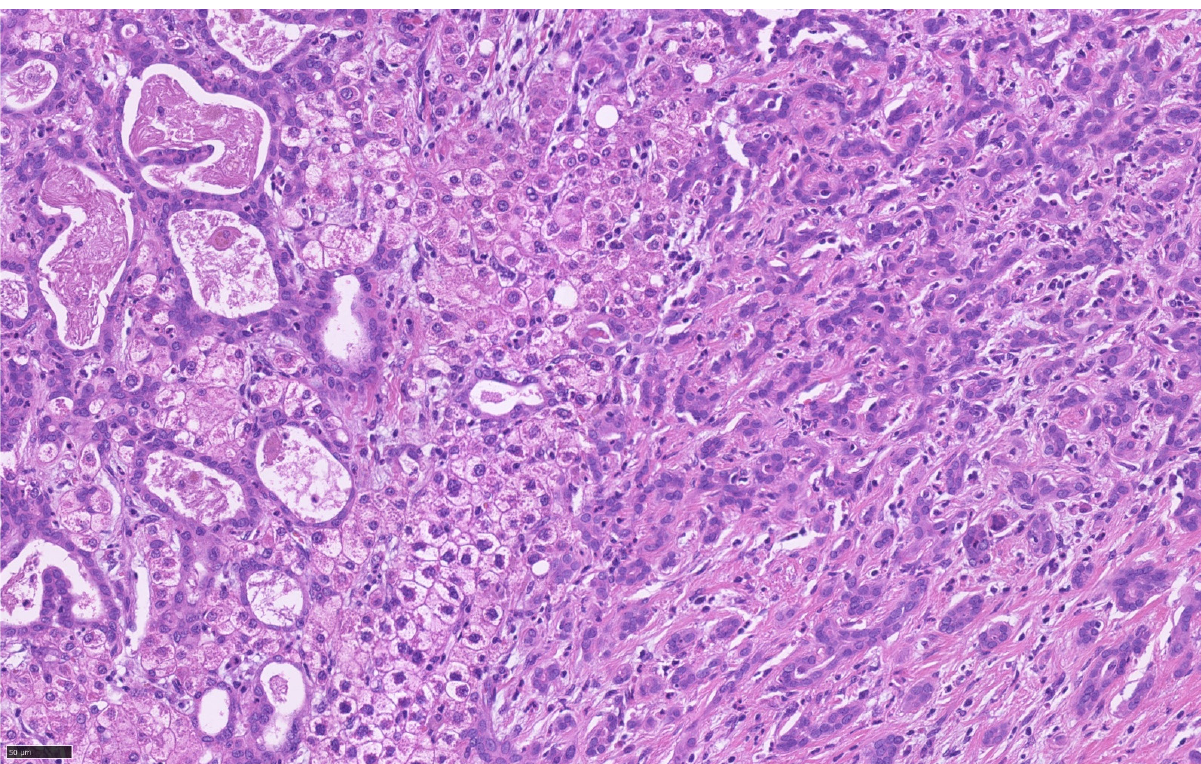
Figure 5. Tumor heterogeneity of cHCC-CCA which exhibits large duct iCCA component (left), HCC component (middle), and small duct iCCA component (right).